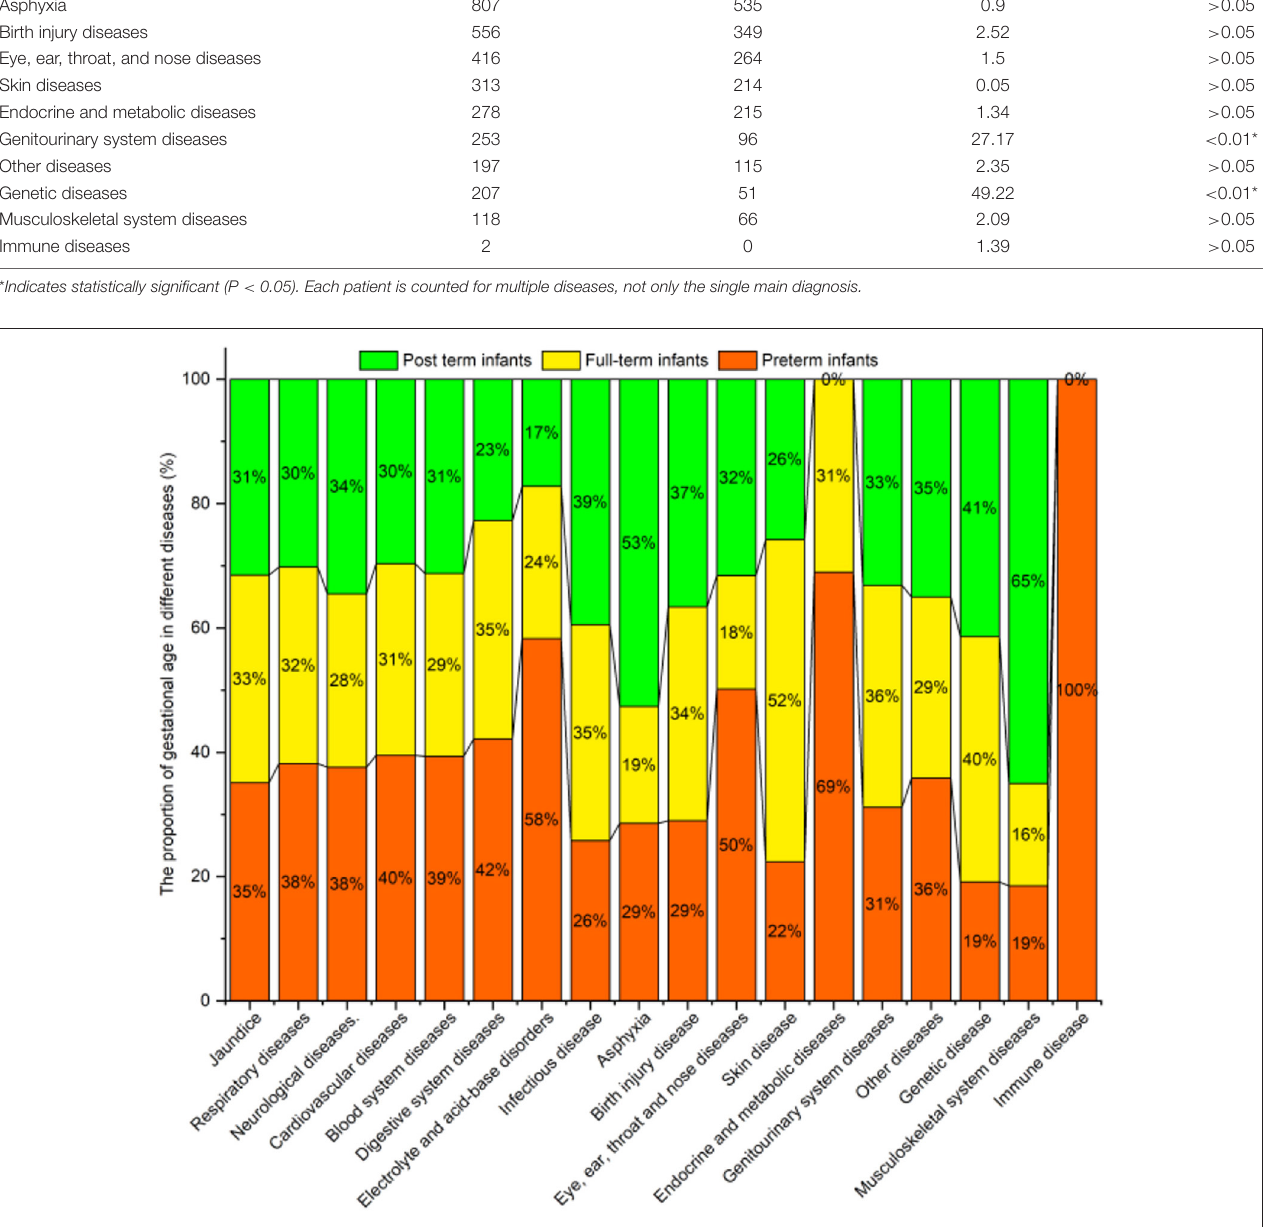
FIGURE 10 | Neonatal diseases and distribution by gestational